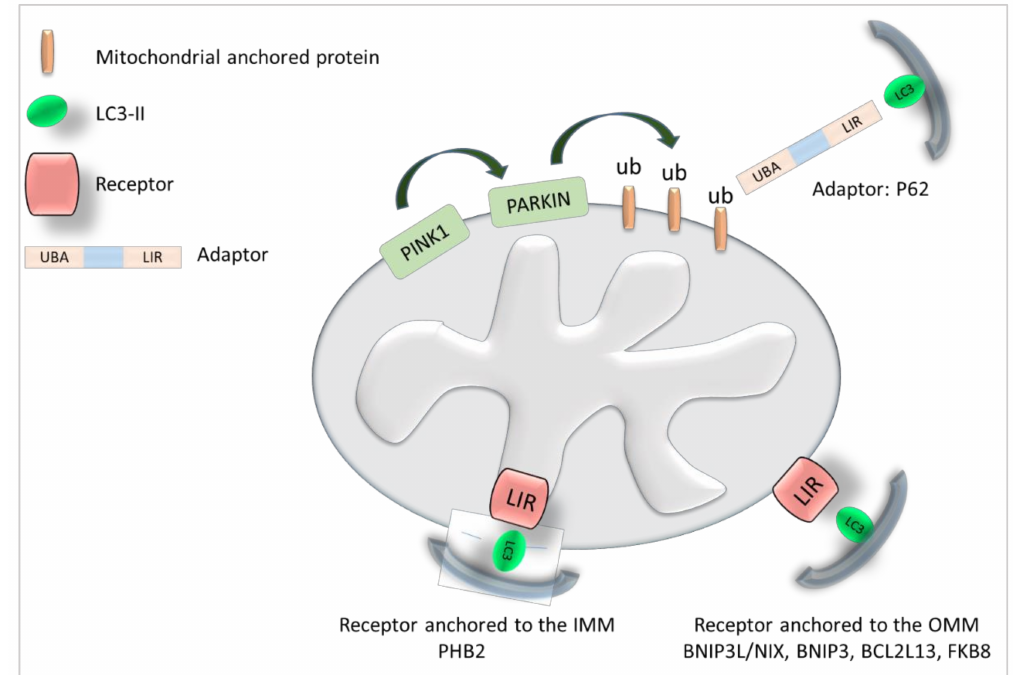
Figure 2. The specific targeting of mitochondria to autophagosomes is mediated by adaptors and receptors. Mitophagy specificity is ensured by mitophagic receptors anchored to the OMM (BNIP3L/NIX [8], BNIP [9], P3BCL2L13 [10], PHB2 [11] and FKBP8 [12]) or to the inner mitochondrial membrane (IMM) and by cytoplasmic adaptors, such as P62 [13]. Mitophagy induction involves the kinase PINK1 and the E3 ubiquitin-protein ligase Parkin. After mitochondrial depolarization, PINK1 accumulates at the OMM and activates Parkin by phosphorylation, allowing its mitochon- drial recruitment. Parkin ubiquitinates OMM proteins [14] that are recognized by adaptors, such as P62/sequestosome 1, for autophagic elimination [15]. LC3-II interacts with the LIR motif of adaptors and